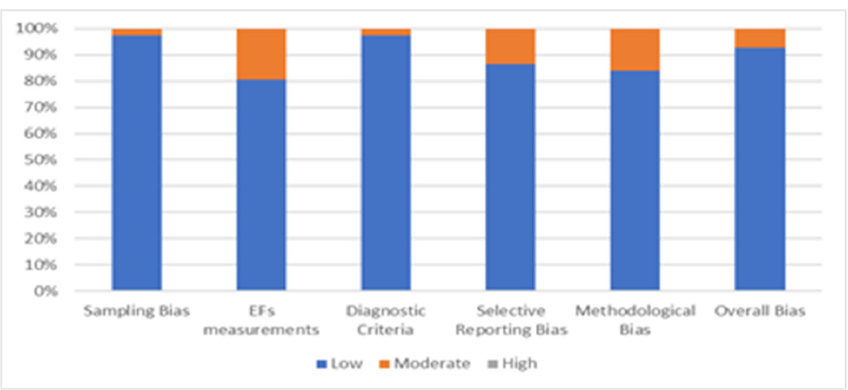
Figure 2. Risk Bias of selected articles, considering all higher executive functions.